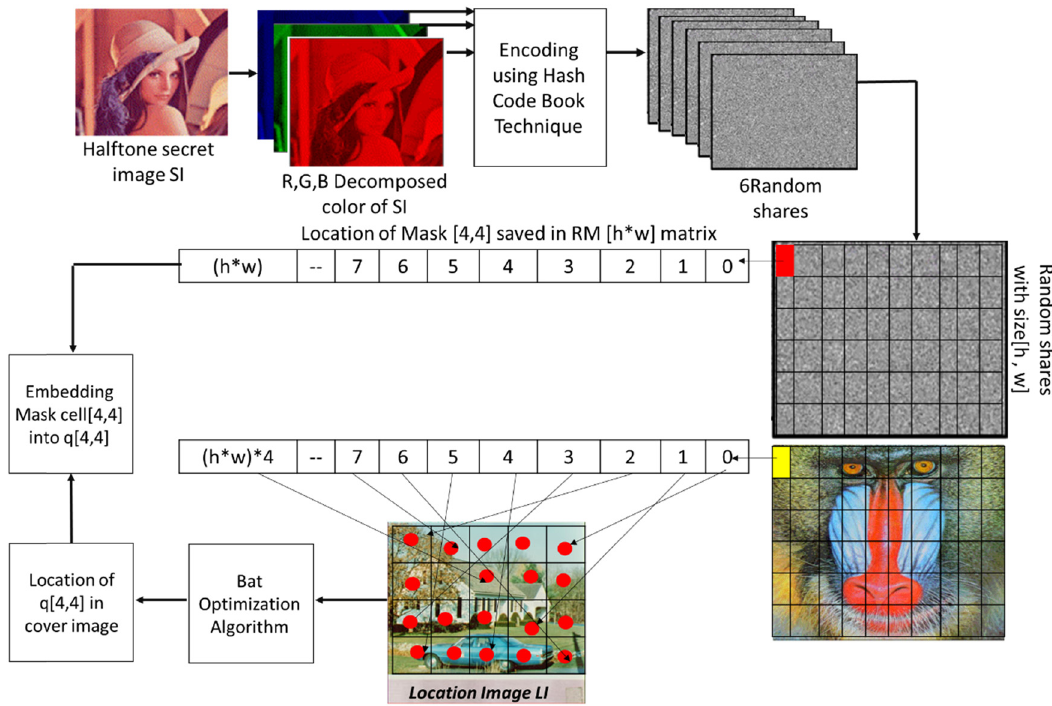
Figure 8: Distributing SIP into cover image based on the